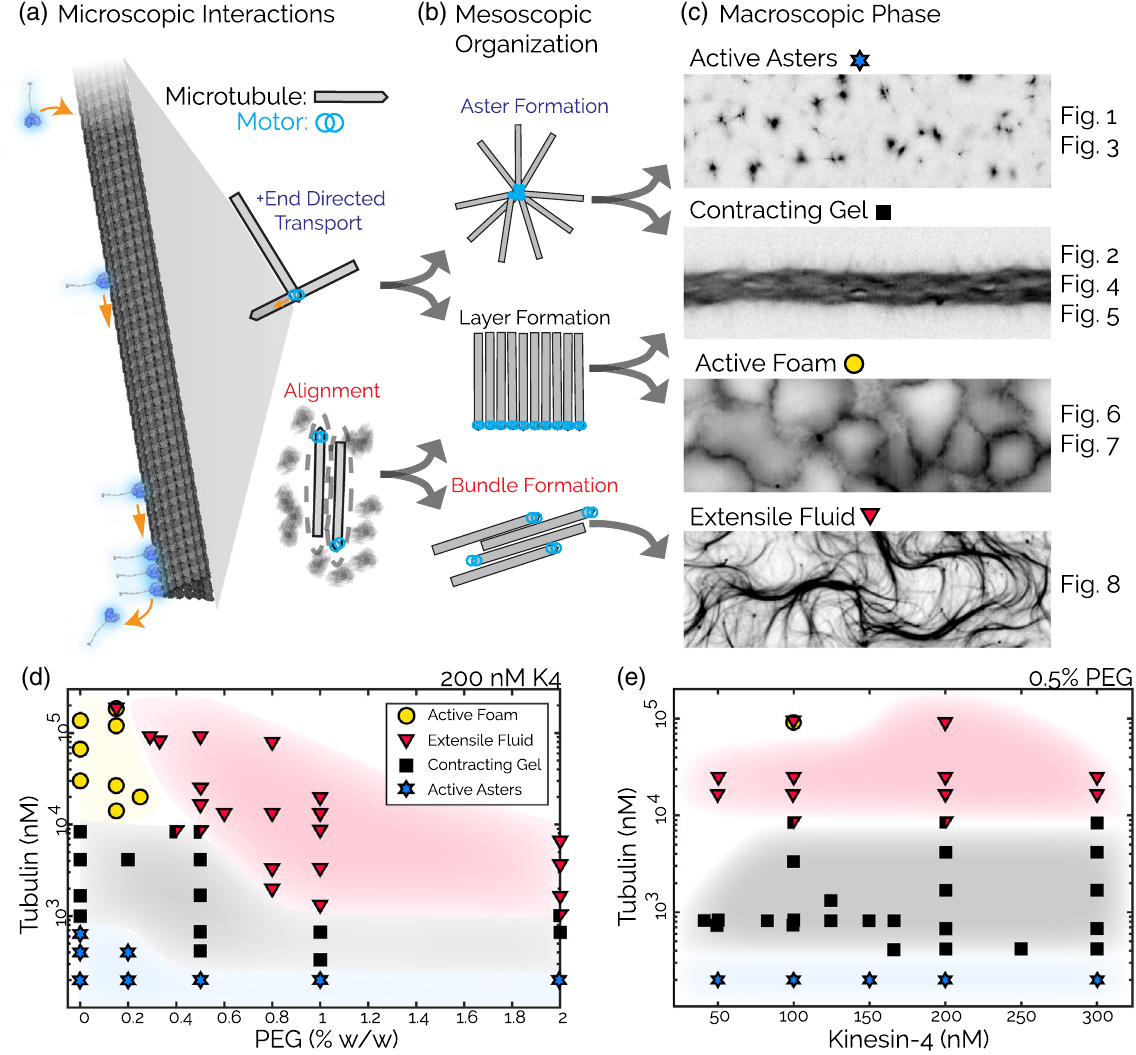
FIG. 9. A nonequilibrium phase diagram of kinesin-4 and microtubules. (a) Microscopic building blocks: Kinesin-4 (blue) attaches to a microtubule (gray), walks to the microtubule plus end, and accumulates at the plus end, creating a heterogeneous filament that can interact with other filaments by directed transport or via steric alignment induced by PEG. (b) Mesoscale organizational motifs include asters, layers, or bundles. (c) Hierarchically organized mesoscale building blocks yield macroscopic phases including dynamic asters, globally contracting gels, active bilayer foams, and fluidized extensile bundles. (d) Phase diagram at 200 nM kinesin as a function of tubulin and PEG concentration. (e) Phase diagram at 0.5% PEG (w = w) as a function of protein